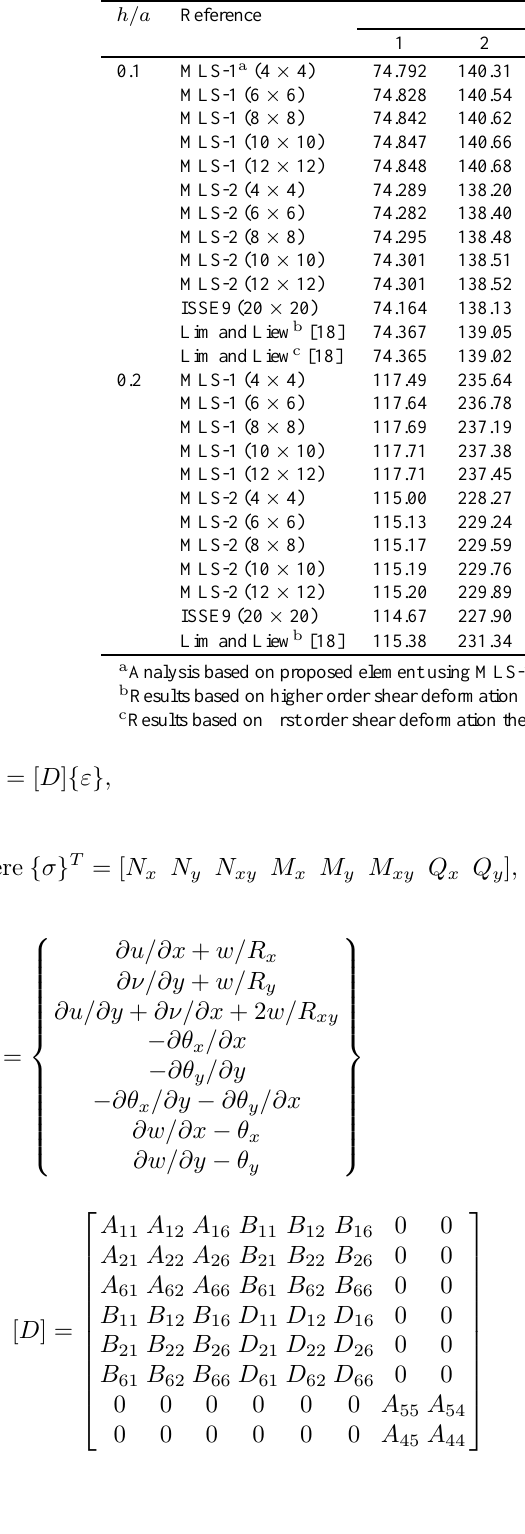
Frequency parameters (100 ωa